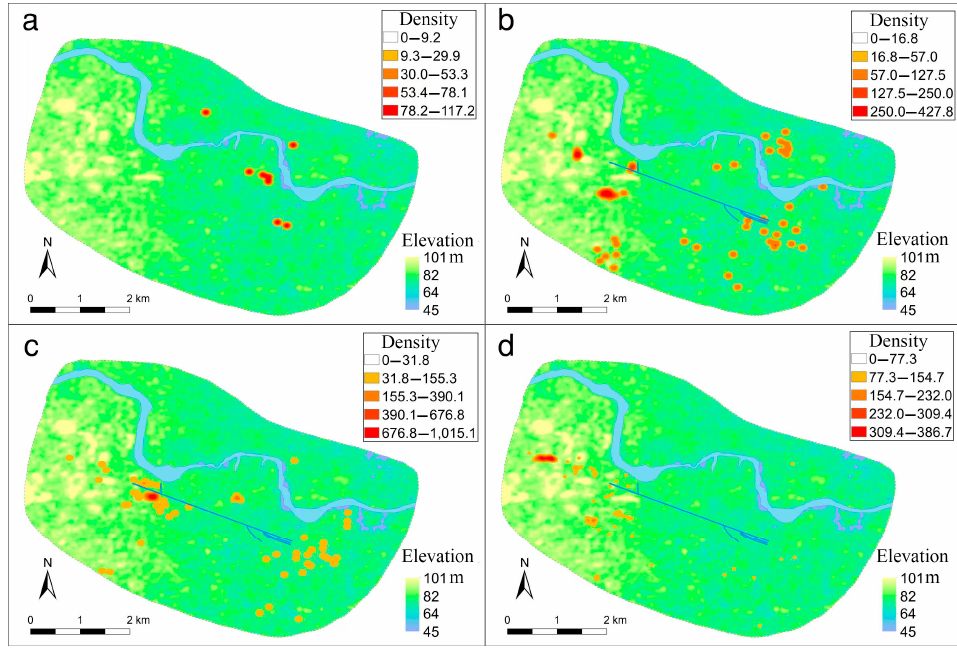
Figure 9. Distribution of warrior burial sites at Yinxu in different phases: ( a ) First Phase; ( b ) Second Phase; ( c ) Third Phase; ( d ) Fourth